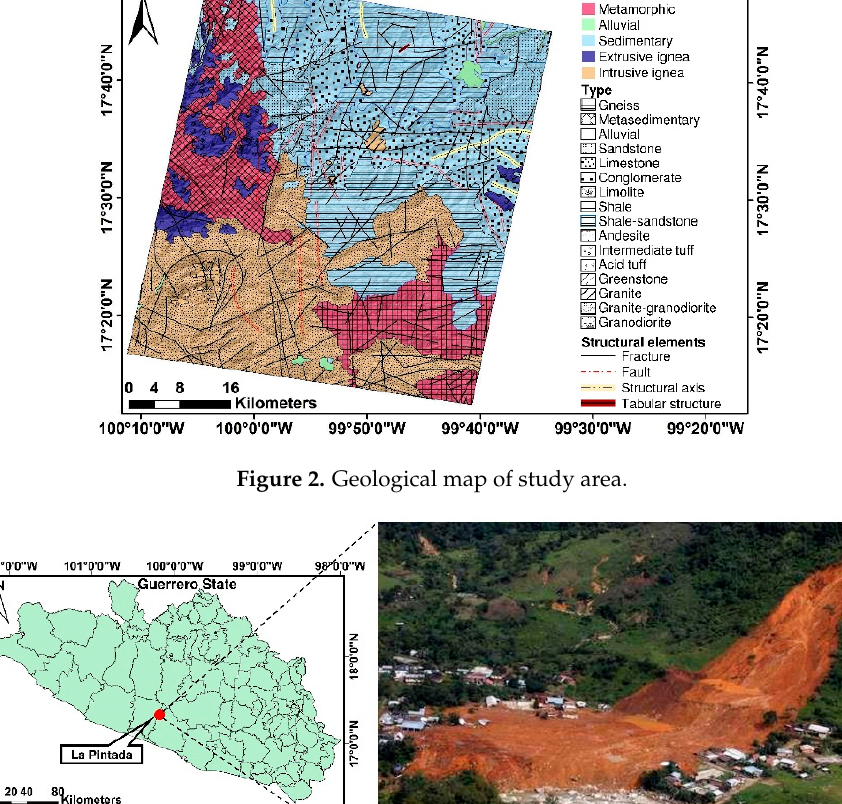
Figure 2. Geological map of study area.